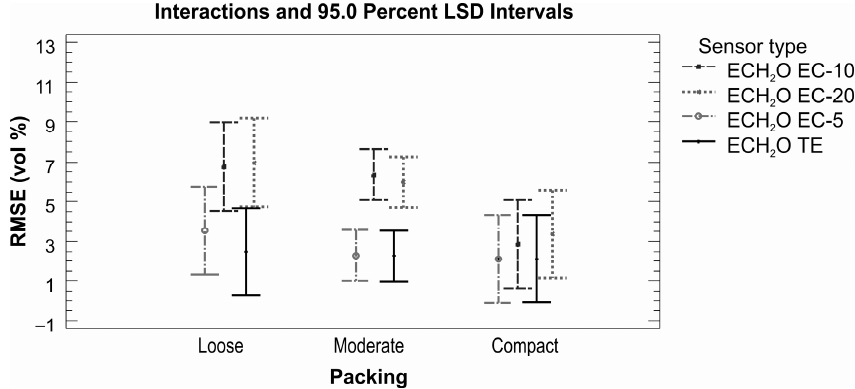
Figure 11. Sensors from the ECH 2 O family—sensor performance comparison based on RMSE (vol %) values for different dry bulk density levels.